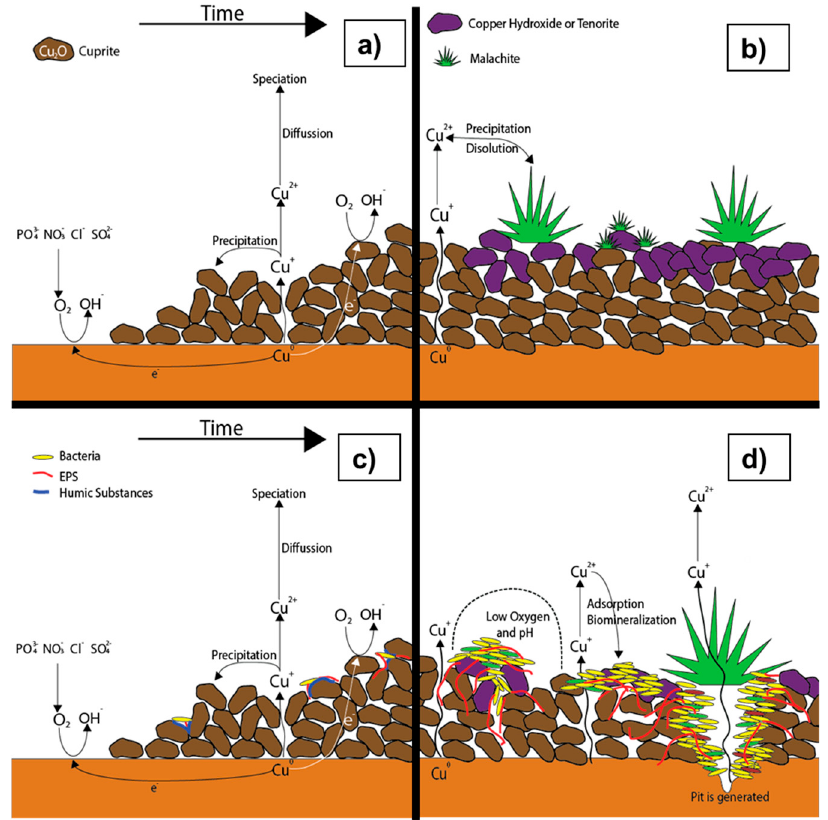
Figure 5. Conceptual corrosion model in copper pipes under stagnation. Abiotic conditions: ( a ) Within a few days, a porous and semiconducting cuprite layer that limits copper ion diffusion is formed, this process being the limiting step in corrosion. Anions present in the water competes with oxygen adsorption sites; ( b ) As cupric ions reach supersaturation, they precipitate forming more passivating scale, which can take months or years. Biotic conditions: ( c ) Humic substances adhere on the surface, letting bacteria grow; and ( d ) as time passes, the biofilm develops, creating low oxygen and pH environments and eventually pits that may cause pipe failure in a few years.